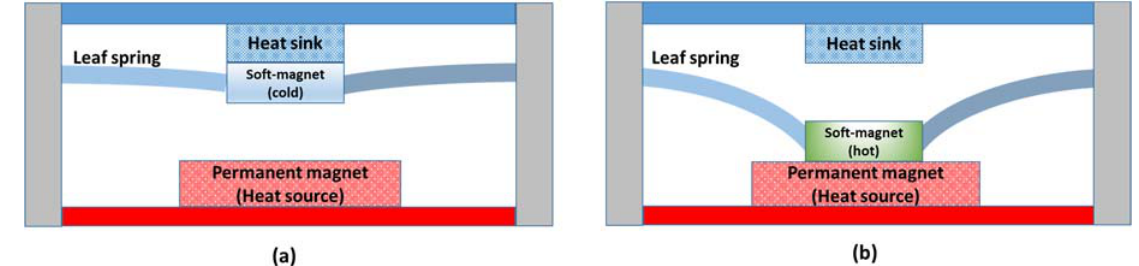
Figure 20. Thermomechanical actuator reported by Ujihara et al. ( a ) Soft magnet is ferromagnetic; ( b ) soft magnet is paramagnetic, adapted from [142,179], with permission from © 2018 Elsevier.